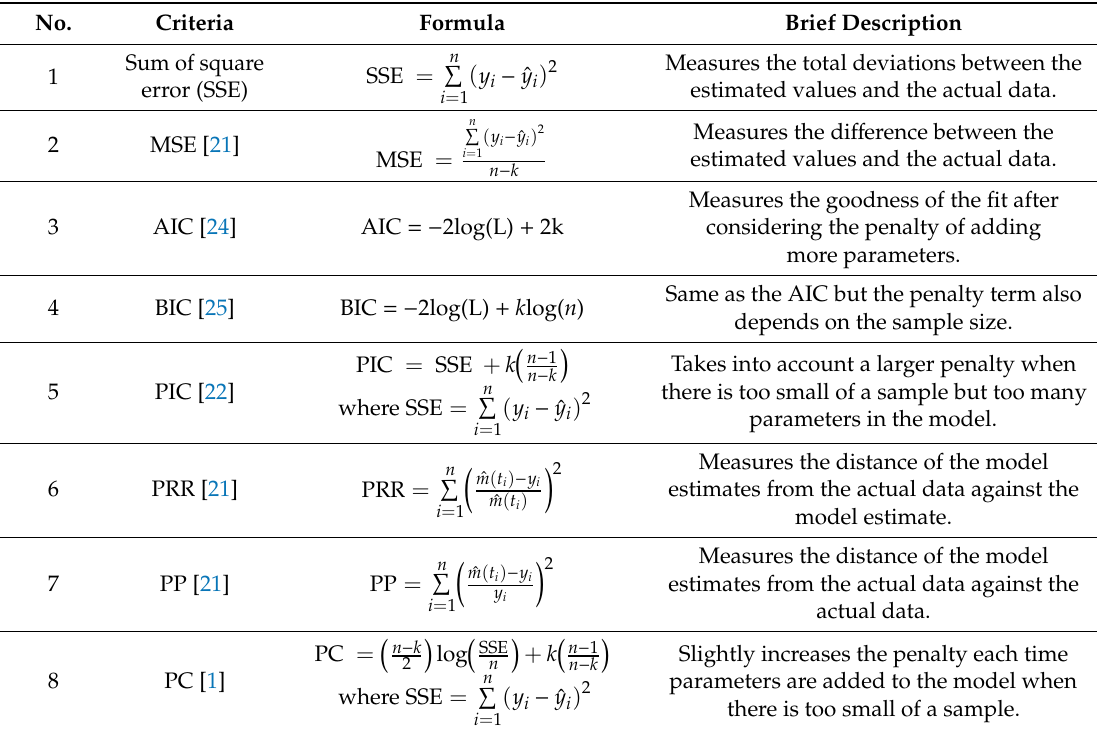
Table A2. Model selection criteria